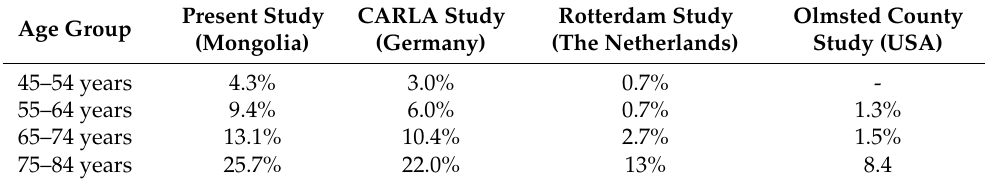
Table 8. Prevalence of heart failure in Mongolia compared with other population-based